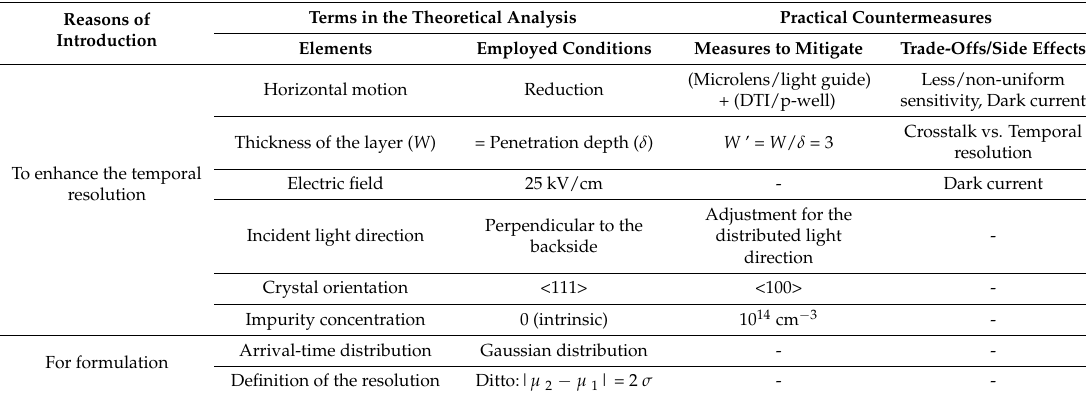
Table 3. Modification of conditions used in the theoretical analysis for designing practical